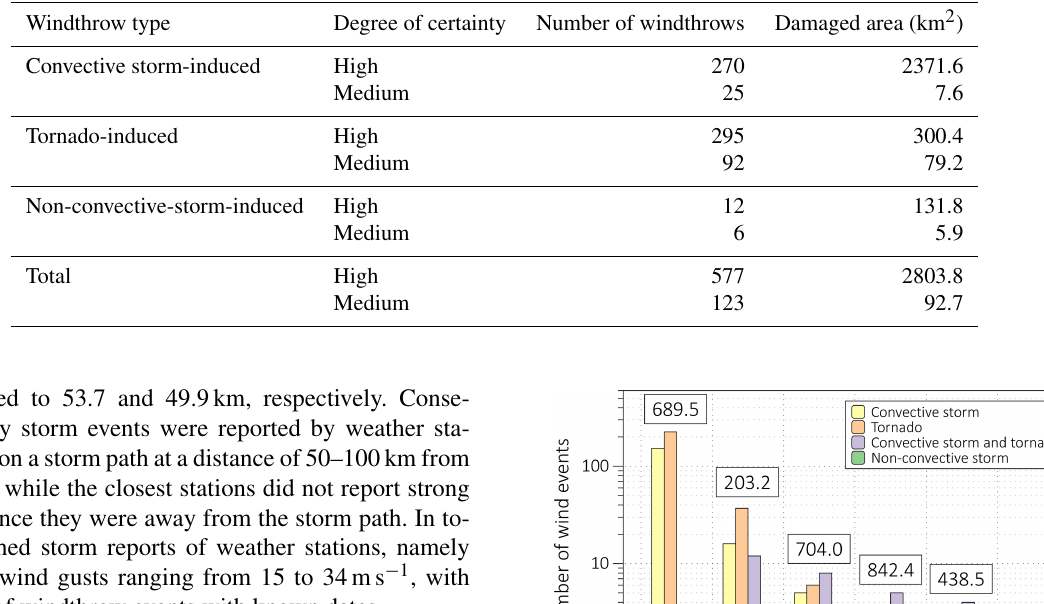
Table 7. Total number of windthrow events of different types and corresponding damaged forested areas.